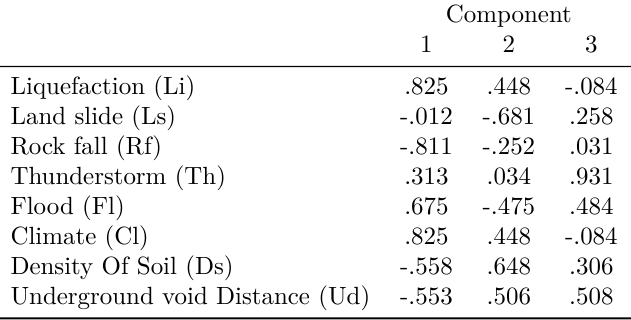
Table 2. Component Matrix.